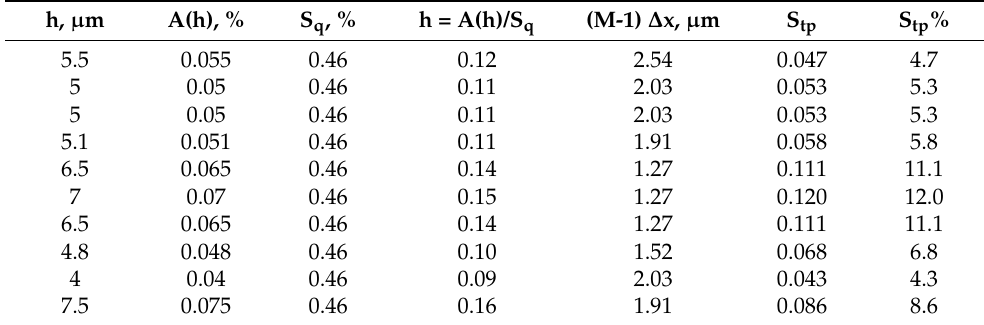
Table 6. The results of calculating the bearing capacity of the laser alloyed surface of AISI 304 steel after wear